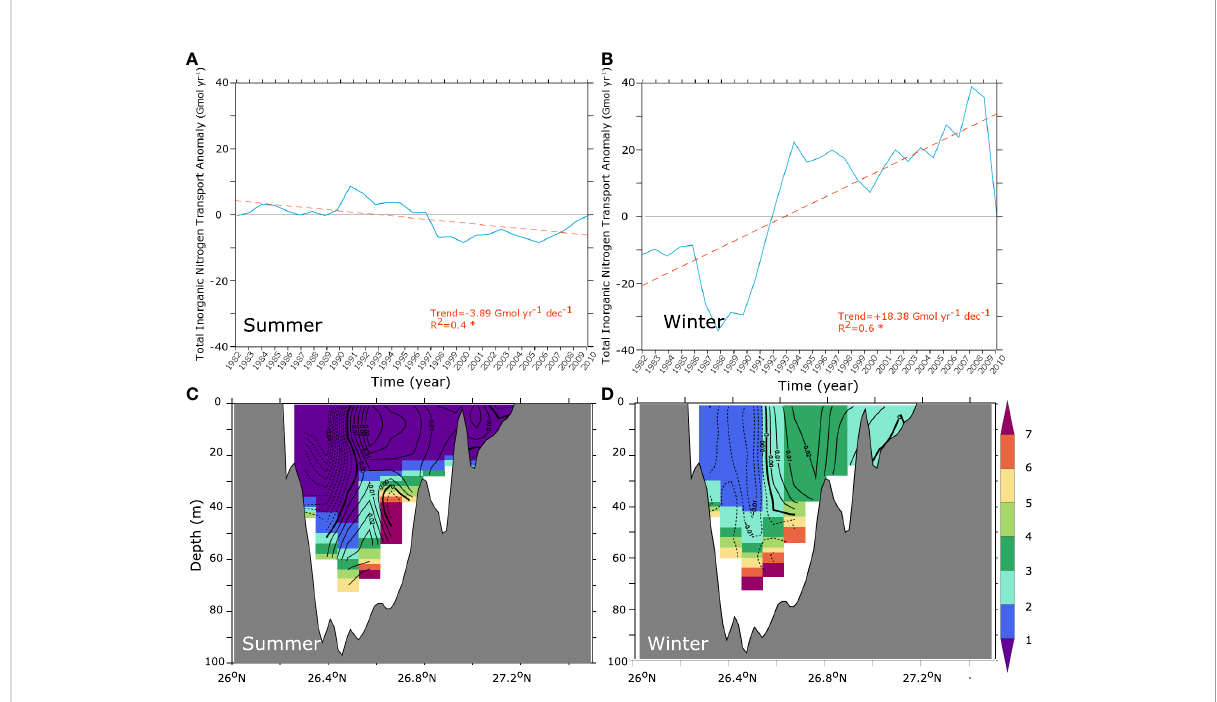
FIGURE 10 Changes in the Gulf nutrient in fl ow. (A, B) Cumulative anomalies of total transport of TIN across the Strait of Hormuz between 1982 and 2010 in the upper 40 m in summer (A) and winter (B) (trend lines are shown in orange). (C, D) Average TIN (color shading, in mmol m -3 ) and change in water velocities through the Strait of Hormuz (contour lines, in m s -1 ; in fl ow positive) between the early 1980s and the late 2000s in summer (C) and winter (D)